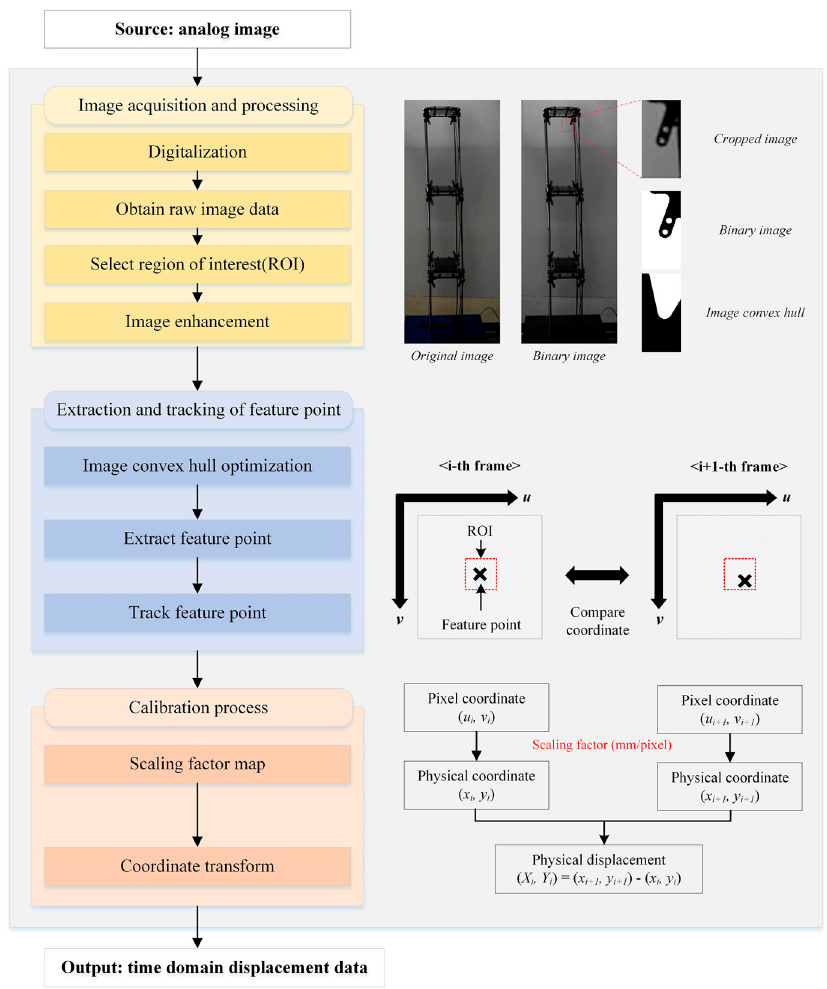
Figure 1. Displacement data acquisition diagram using the target-less vision-based displacement sensor.